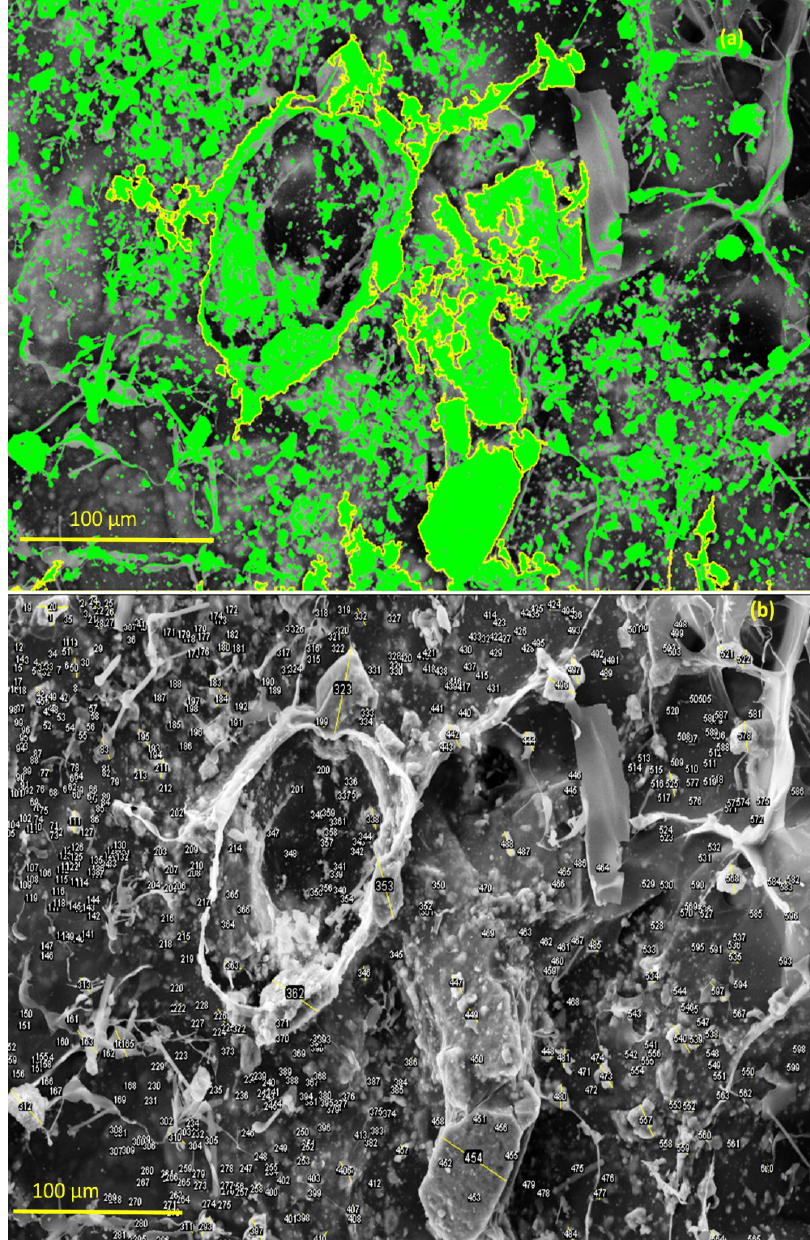
Figure 9. ( a ) Field emission scanning electron microscopy (FESEM) of pure gellan gum ( b ) and FESEM of scaffold.